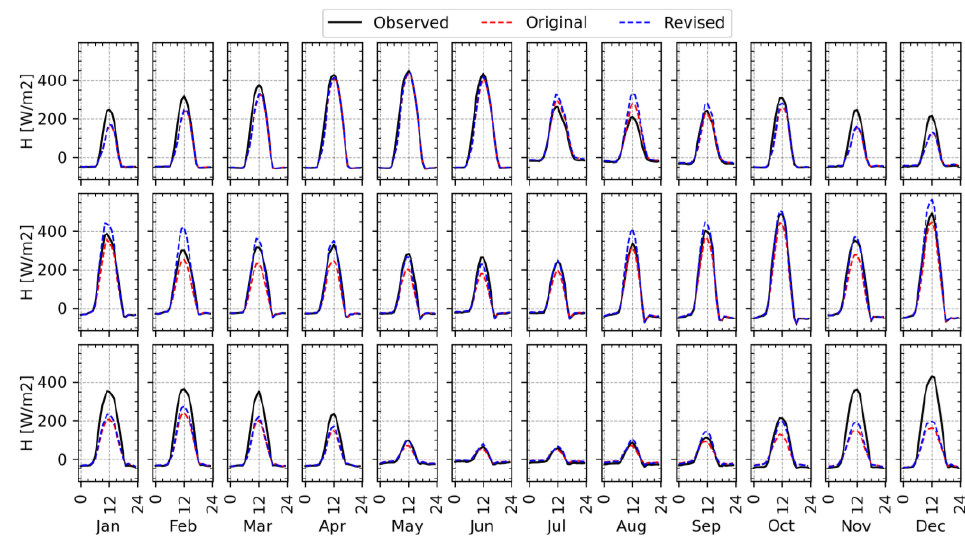
Figure 13. Time-averaged diurnal variations in the observed and simulated sensible heat flux by the original and the revised parameterization at grassland sites. The top row corresponds to the Walnut Gulch Kendall grasslands in the USA (US-Wkg), the middle row to the Emerald site in Australia (AU-Emr), and the bottom row to the Riggs Creek site in Australia (AU-Rig).